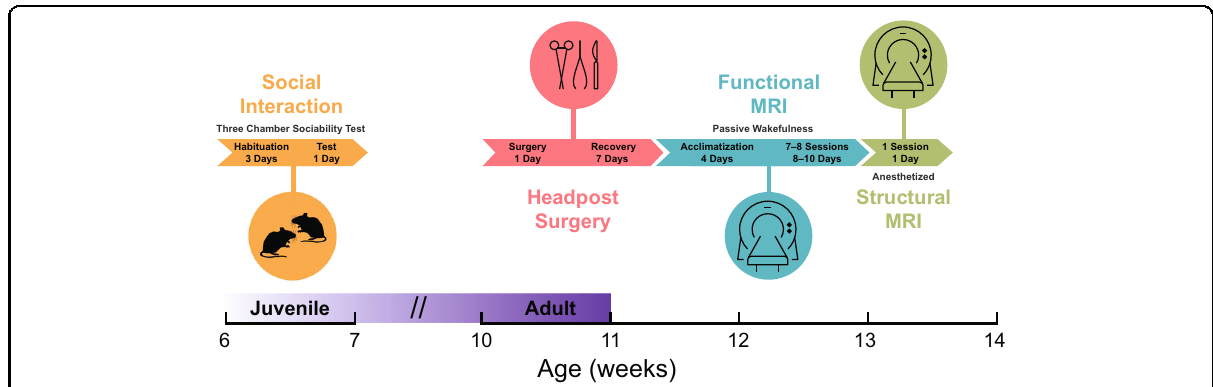
Fig. 1 Experimental protocol. The timeline shows the sequence of experimental steps animals underwent. Social interaction assessment was examined on juvenile mice. At adulthood, the mice underwent a head-post surgery, were allowed to recover, and underwent a 4 days acclimatization period to awake head- fi xed imaging followed by multiple functional MRI sessions for each animal. Finally, a single structural MRI was